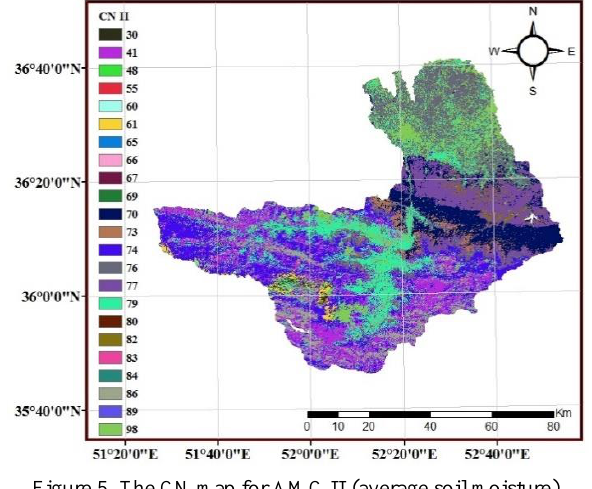
Figure 5. The CN map for AMC II (average soil